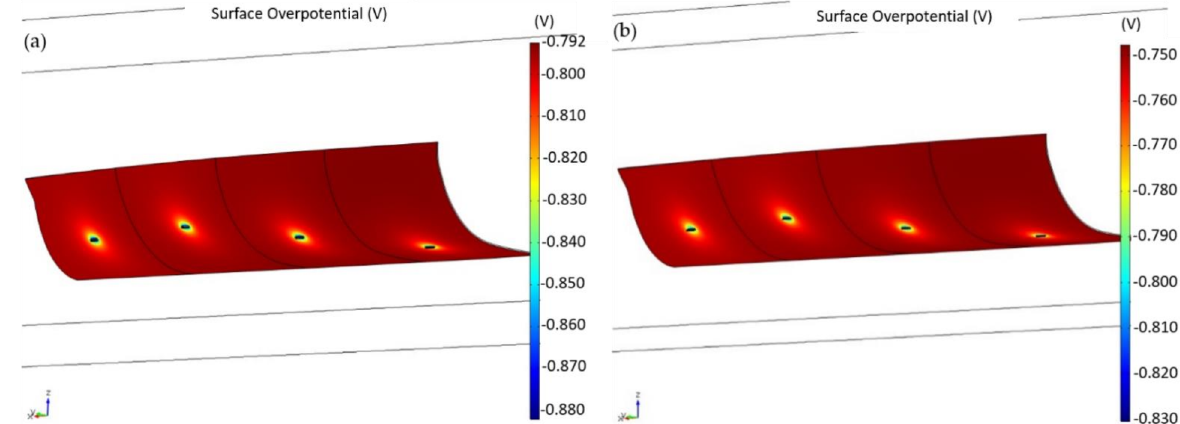
Figure 7. Results of the numerical analysis in the central body with ( a ) all 2.7 kg anodes at the beginning of their lifetimes and ( b ) all 2.7 kg anodes being 80% consumed (final weight 0.54